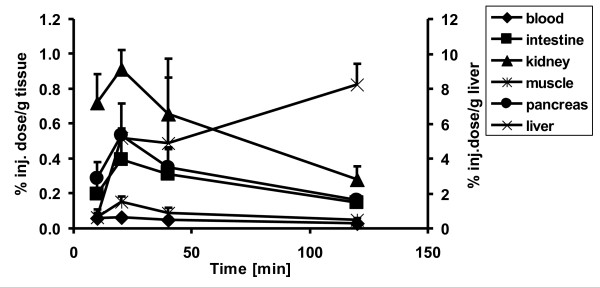
Time course of the [18F]CFT uptake (percent injected dose per gram tissue) by selected organs. The uptake values for the liver are presented in the y-axis on the right.